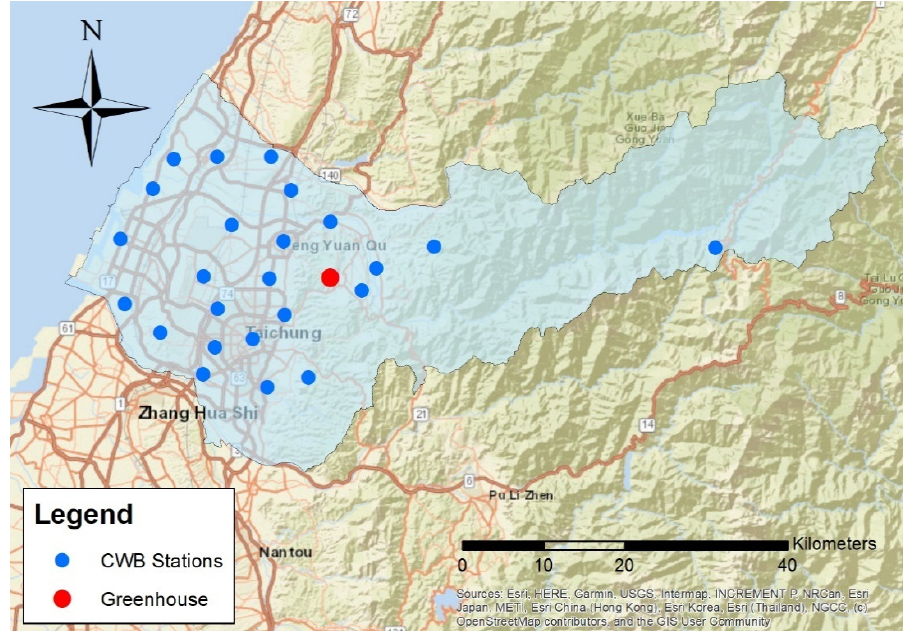
Figure 1. The locations of weather stations.